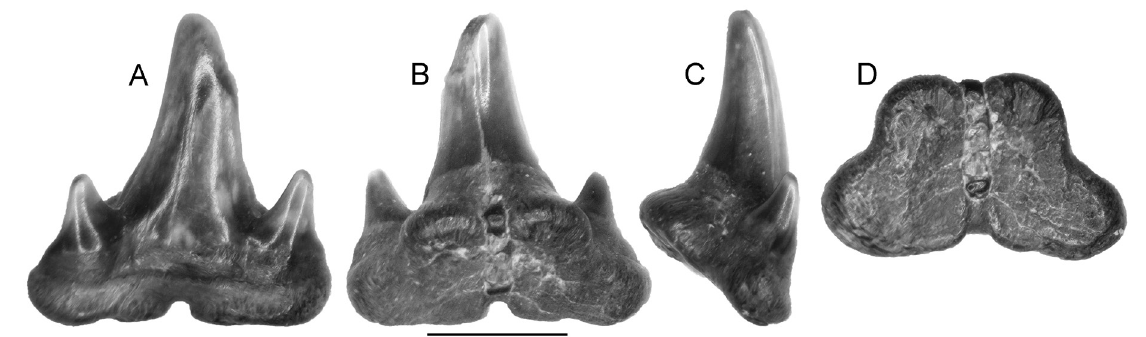
Fig. 21. Premontreia ( Oxyscyllium ) subulidens (Arambourg, 1952), tooth. A–D . ANSP 23421, lateral tooth, Tallahatta/Lisbon contact zone. A . Labial view. B . Lingual view. C . Mesial view. D . Basal view. Scale bar =